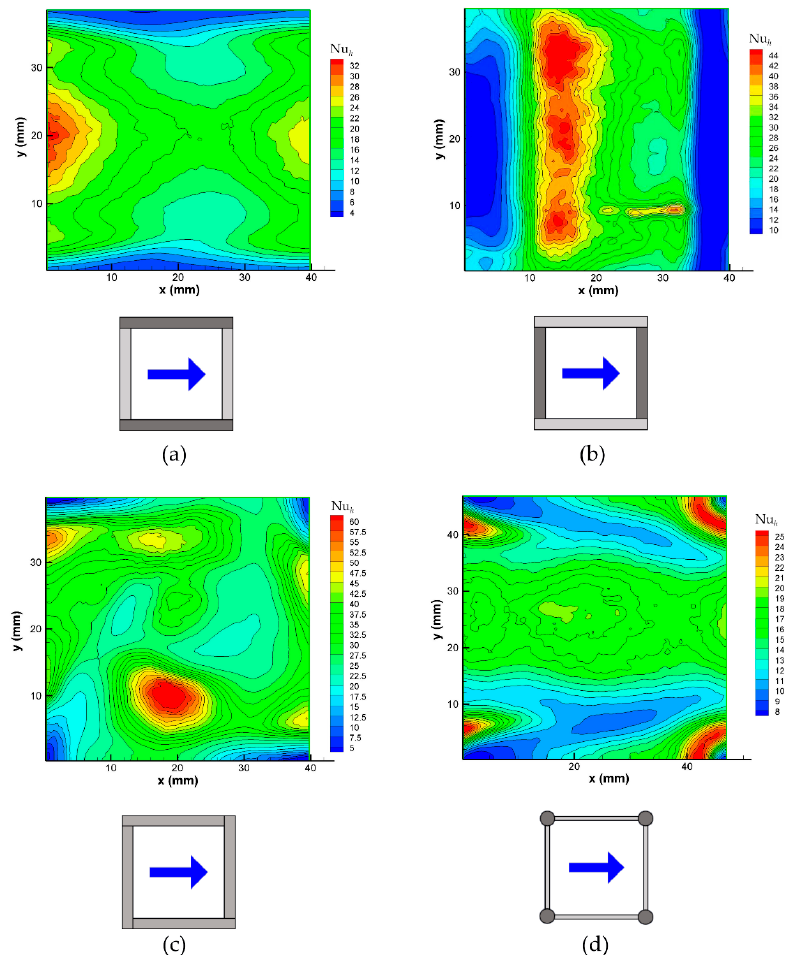
Figure 10. Distributions of the local Nusselt number on a wall for different spacer configurations at a Reynolds number of ~500. ( a ) Overlapped spacer, flow attack angle ϕ = 0°; ( b ) overlapped spacer, ϕ = 90°; ( c ) woven spacer, ϕ = 0–90°; ( d ) spheres spacer, ϕ = 0–90°. Note that for the woven and spheres geometries, there is no difference between the 0° and 90° attack angles.